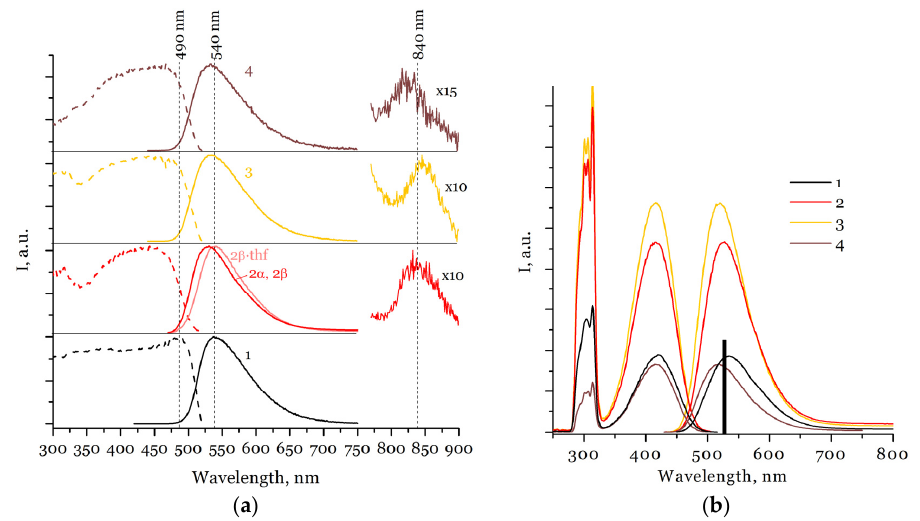
Figure 6. ( a ) Normalized excitation (dashed lines) and emission (solid lines) spectra of solid com- pounds 1 – 4 at room temperature ( b ) The corresponding spectra in toluene solutions (lines; concen- tration 10 − 5 M) and calculated energy for the emission S 1 –S 0 for 1 (bar). Apart the major band, the PL spectra of solid 2 – 4 reveal a weak but notable band in the IR range peaked at ca. 840 nm. Although the experimental emission lifetime was not determined for the IR band due to the poor emission intensity, we can attribute the minor band to a phosphorescence. Indeed, the calculated wavelength for T 1 – S 0 transition well agrees with the experiment (Tables 1 and S7). The intersystem crossing (ISC) promotion